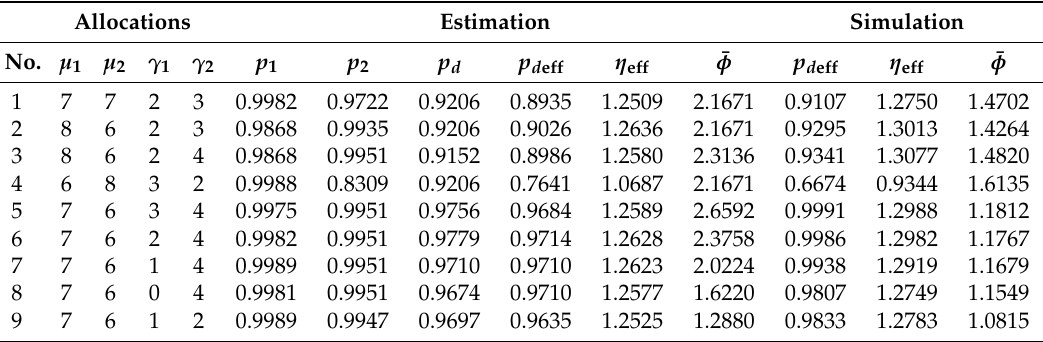
Table 4. Some examples of